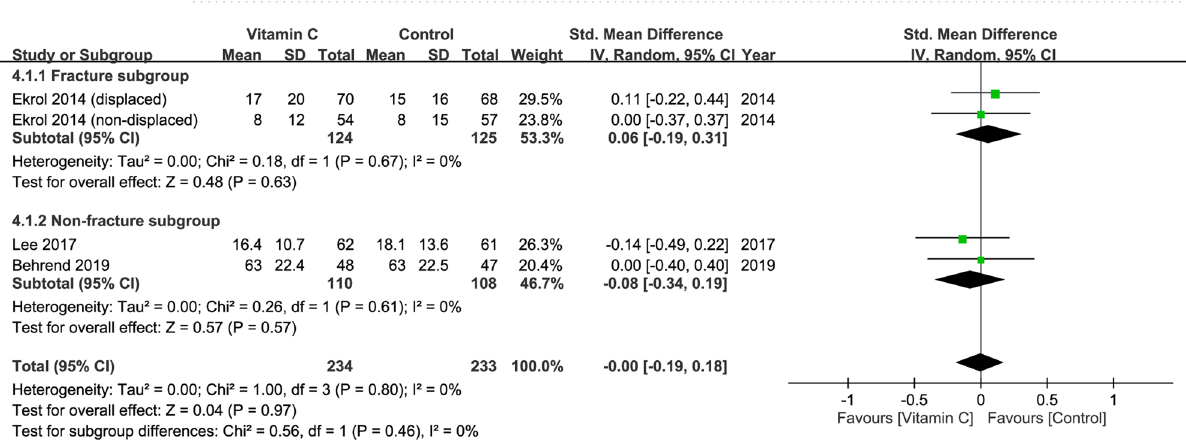
Figure 4. Forest plot for the comparison of function outcomes at 6–12 months between vitamin C and placebo groups. CI, confidence interval; IV, inverse variance; Std.,